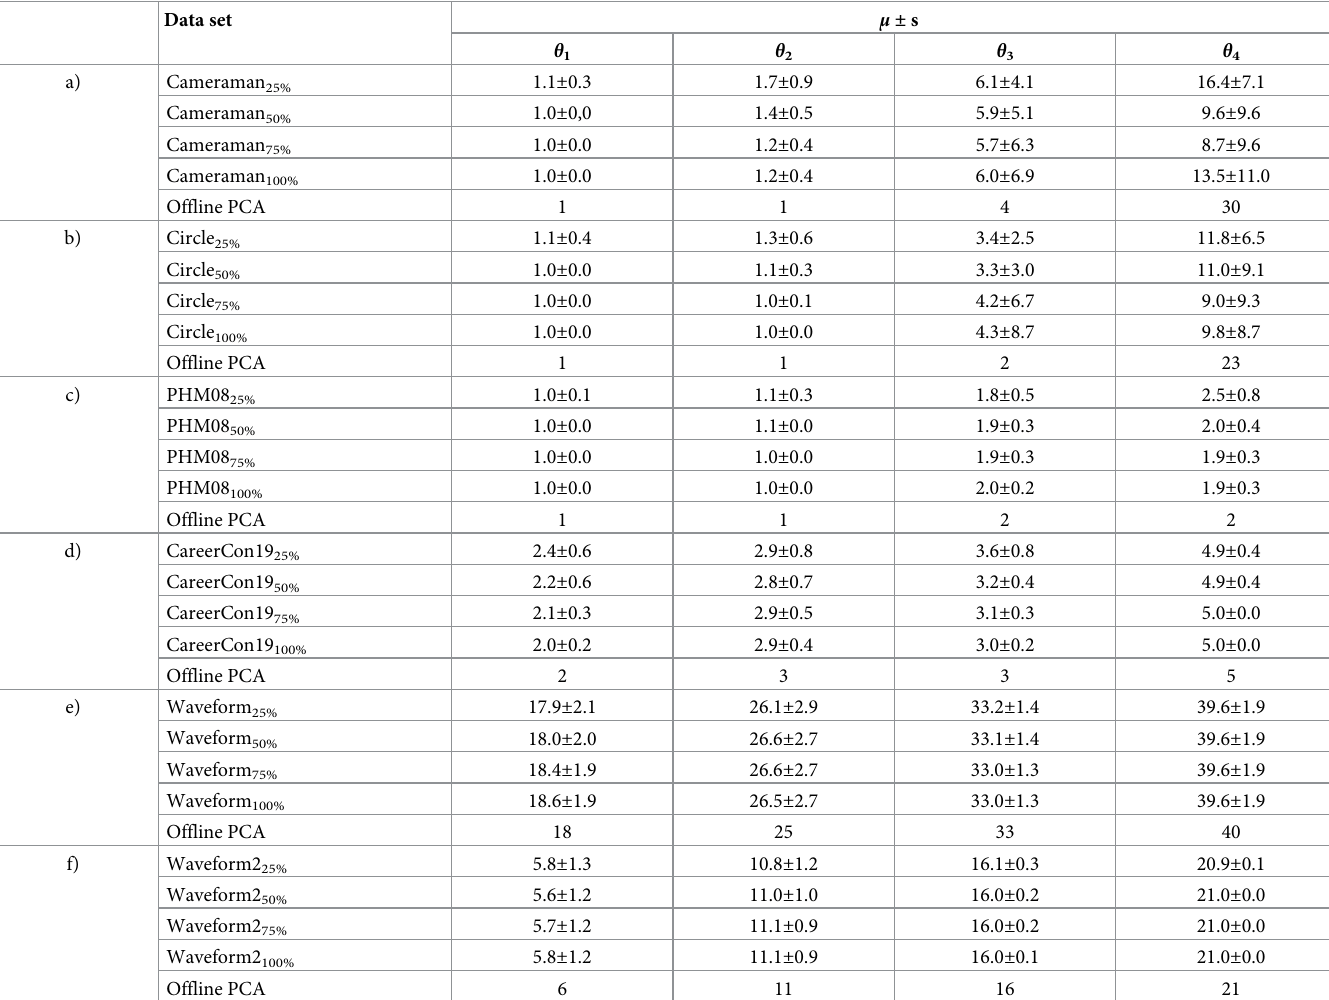
Table 8. Cumulative percentage of total variance with double-logarithmic eigenvalue approximation, θ 1 = 0.7, θ 2 = 0.8, θ 3 = 0.9, θ 4 = 0.99. Data